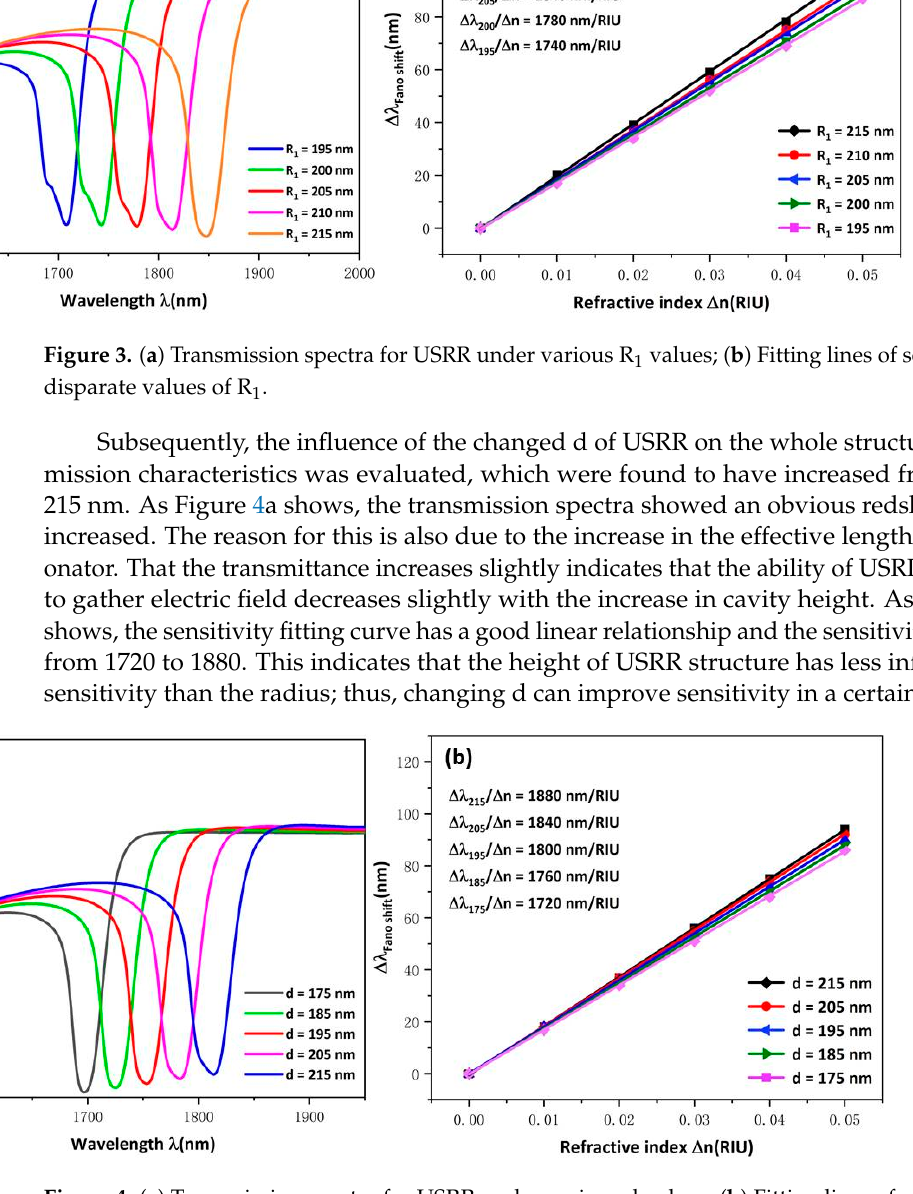
Figure 4. ( a ) Transmission spectra for USRR under various d values; ( b ) Fitting lines of sensitivity at disparate values of